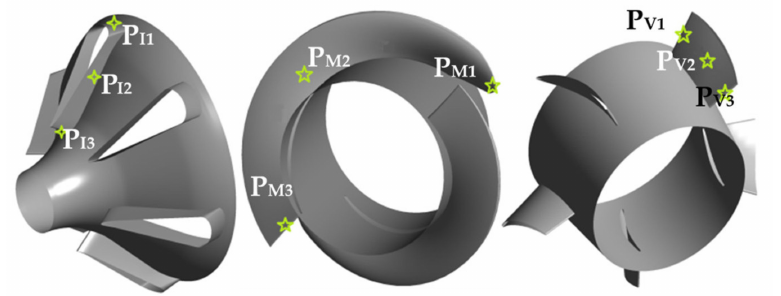
Figure 19. The monitoring points on the blade